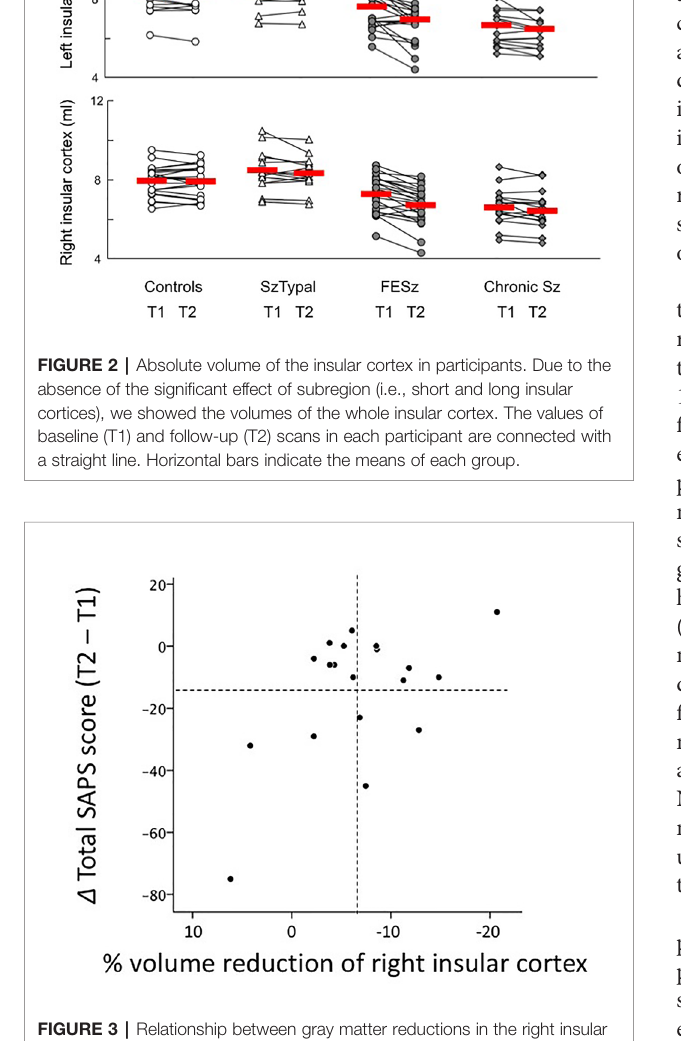
FIGURE 3 | Relationship between gray matter reductions in the right insular cortex over time and score changes in Scale for the Assessment of Positive Symptoms (SAPS) between baseline (T1) and follow-up (T2) scans (i.e., absolute total score at T2 - absolute total score at T1) in 19 patients with fi rst-episode schizophrenia. Regarding % volume reductions, negative values indicate volume decreases. Dotted lines indicate the mean values (all values in the fi gure are within three standard deviations of the